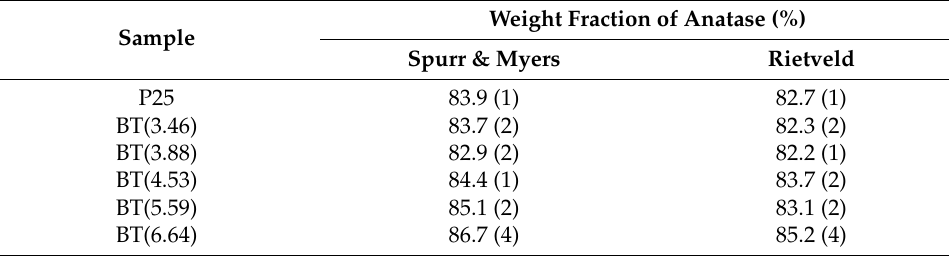
Table 2. Anatase fraction in the samples calculated from DRX data.